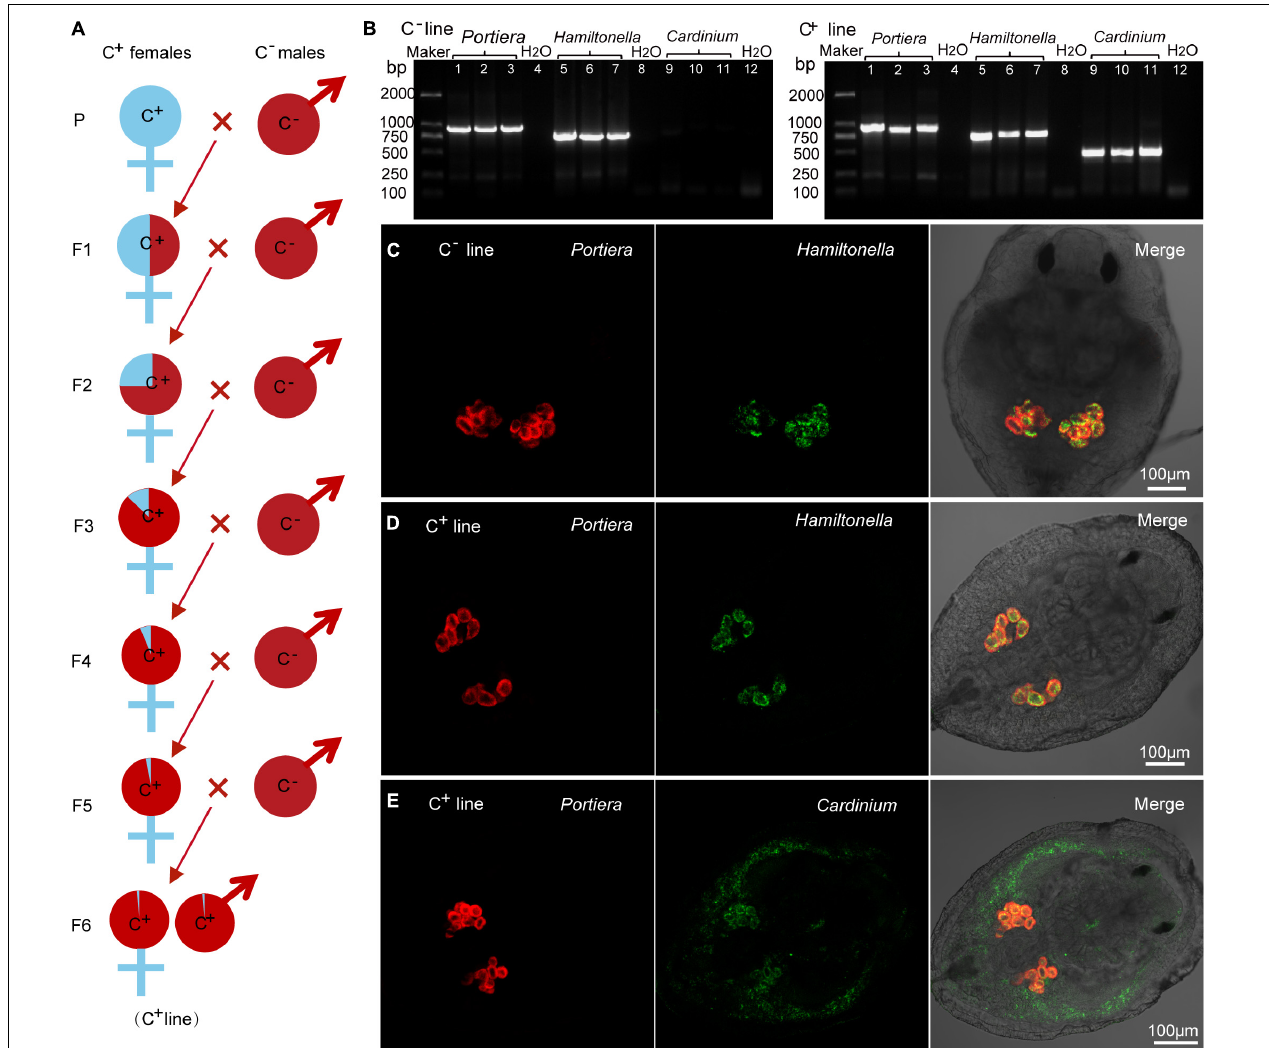
FIGURE 2 | The presence/absence of symbionts in Cardinium- positive (C + ) and Cardinium- free (C − ) whitefly lines. (A) Establishment of C + and C − whitefly lines via introgression. The male C − whiteflies were introduced to mate with female C + whiteflies for 6 generations to homogenize their nuclear background. P: parental generation; F1–F6, the first to sixth filial generations. (B) Portiera , Hamiltonella and Cardinium were detected in C + line, and Portiera and Hamiltonella but not Cardinium were detected in C − line. Lane 1–3: Portiera ; lane 5–7: Hamiltonella ; lane 9–11: Cardinium ; lane 4, 8, and 12: negative control (ddH 2 O). (C) The spatial distribution of Portiera (red) and Hamiltonella (green) in the C − line whitefly. (D) The spatial distribution of Portiera (red) and Hamiltonella (green) in the C + line whitefly. (E) The spatial distribution of Portiera (red) and Cardinium (green) in the C + line whitefly.